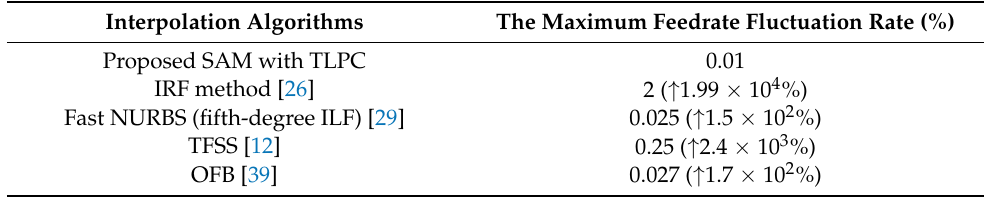
Table 2. Simulation results of different interpolation